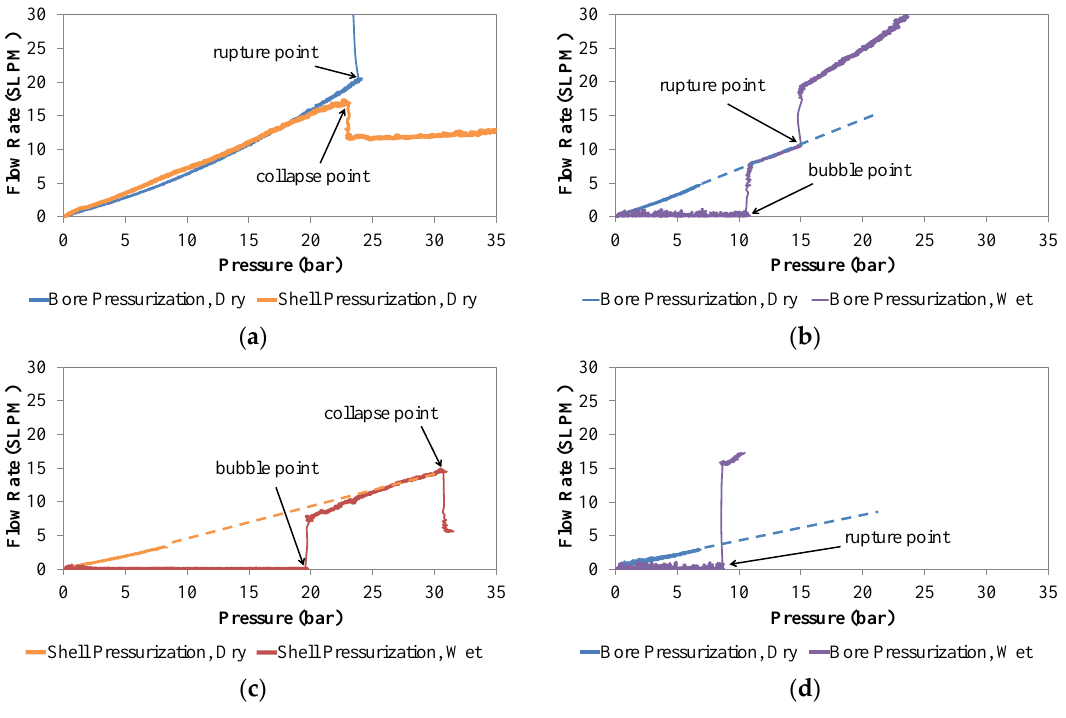
Figure 2. Flow rate (in standard liters per minute, supported ionic liquid membranes (SLPM)) versus pressure curves (in bar) depicting: ( a ) rupture/collapse point for dry hollow fibers; ( b ) bubble and rupture points for a wetted hollow fiber pressurized from the bore side; ( c ) bubble and collapse points for a wetted hollow fiber pressurized from the shell side; ( d ) rupture point for a wetted hollow fiber pressurized from the bore side in which the rupture point occurs at a lower pressure than the bubble point. The extrapolated portions of the dry fiber pressurization curves are indicated with a dashed line.